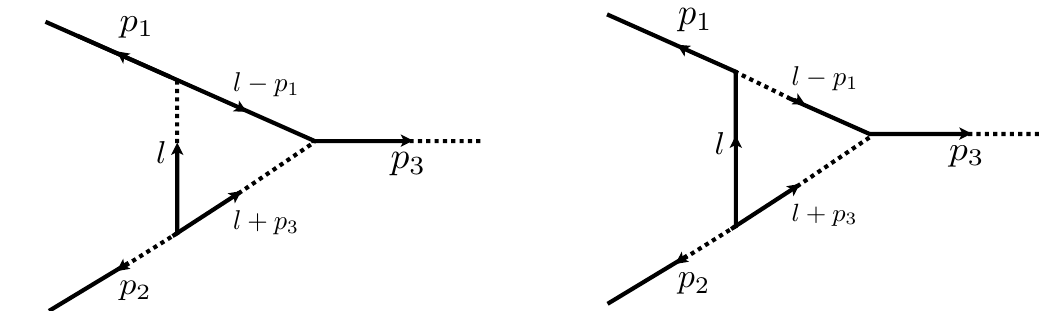
Figure 8 . The Feynman diagrams for the one-loop renormalization of g . The shown diagrams correct the correlator h ϕ ( p